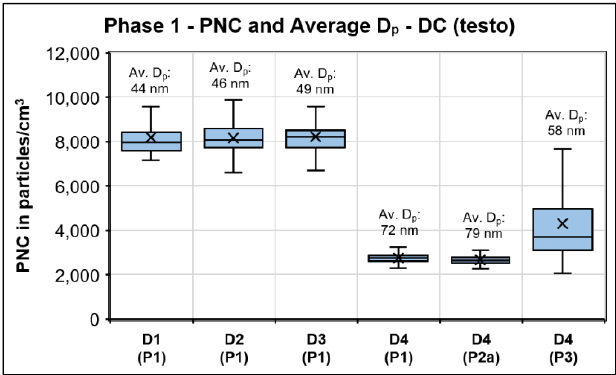
Figure 10. PNC box plot and average D p during phase 1.